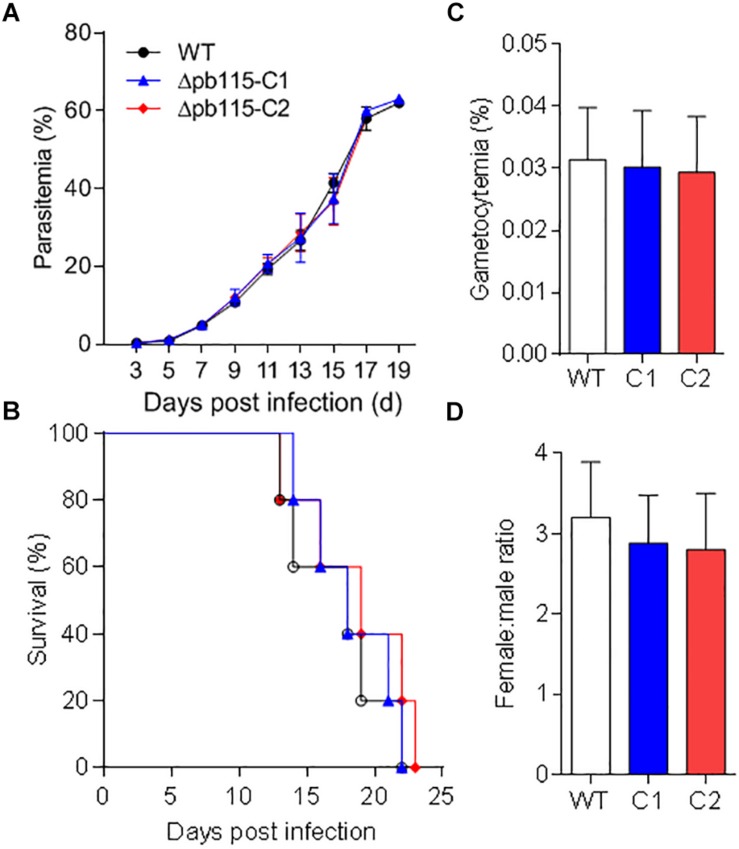
Functional analysis of Pb115 during parasite blood stages. Mice were infected with P. berghei or Δpb115 parasites Clone 1 (C1) and Clone 2 (C2). (A) Growth curve of asexual stages (10 mice per group). (B) Survival rates of mice infected with different parasite strains (10 mice per group). (C) Gametocytemia on day 3 after infection by different parasite strains (five mice per group). (D) Female: male gametocyte ratios on day 3 after infection by WT P. berghei and Δpb115 clone 1 and 2 (five mice per group). The data are from three biological experiments and are presented as the mean ± SD in each group.